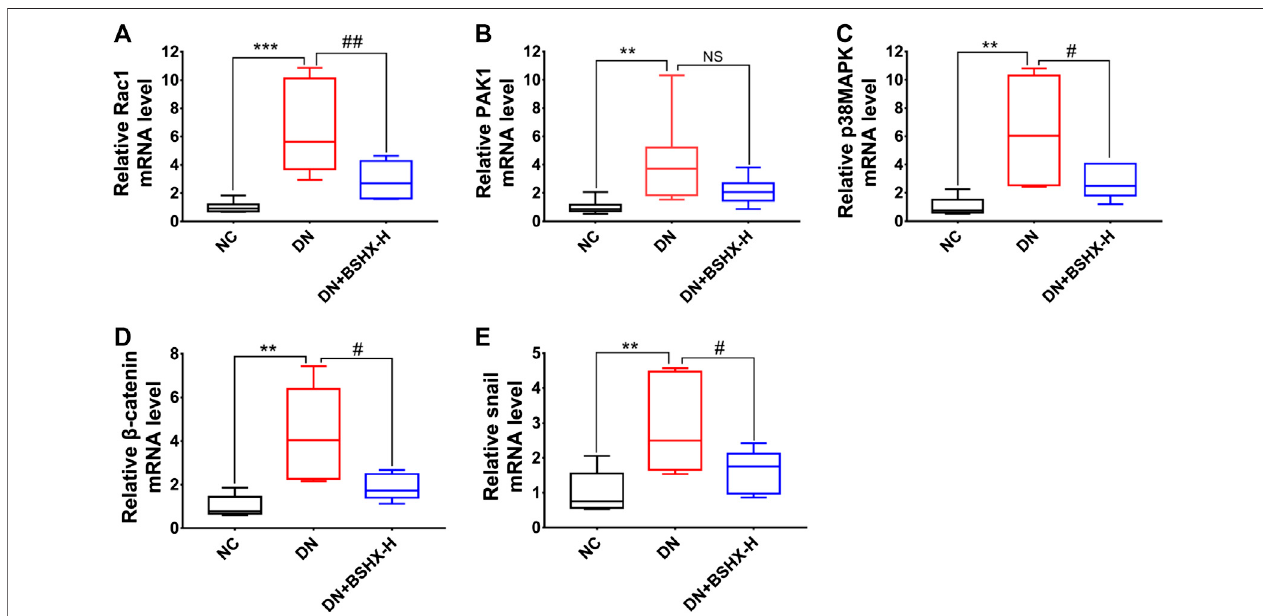
FIGURE8| EffectofBSHXdecoctiononRac1/PAK1/p38MAPKsignalingpathwaymRNAexpressioninDNmousekidney. (A) RelativemRNAexpressionlevelsof Rac1 . (B) Relative mRNA expression levels of Pak1 . (C) Relative mRNA expression levels of p38Mapk . (D) Relative mRNA expression levels of β -Catenin . (E) Relative mRNA expression levels of Snail . The 2 − ΔΔ Ct method was used to analyze relative gene expression. n (cid:1) 5 mice per group. All data are expressed as means ± SEM. * p < 0.05, ** p < 0.01, *** p < 0.001 vs. the NC group; # p < 0.05, ## p < 0.05, ### p < 0.001 vs. the DN model group.